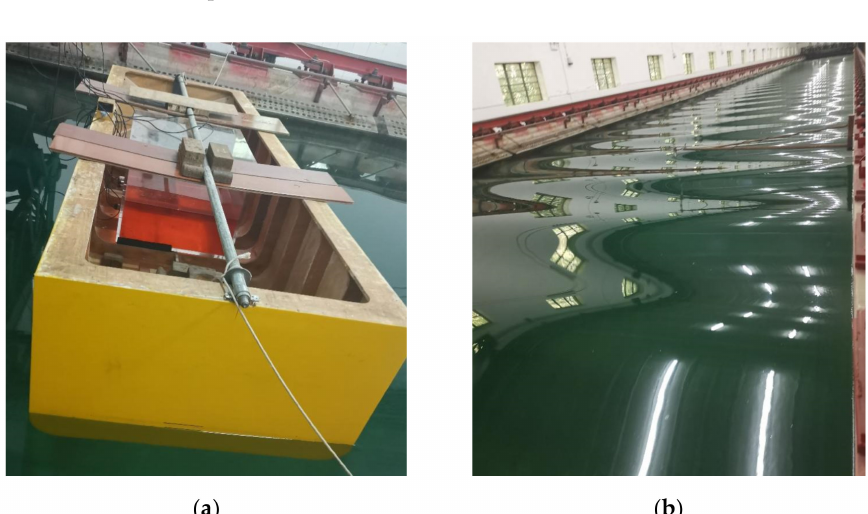
Figure 1. Model size parameters.